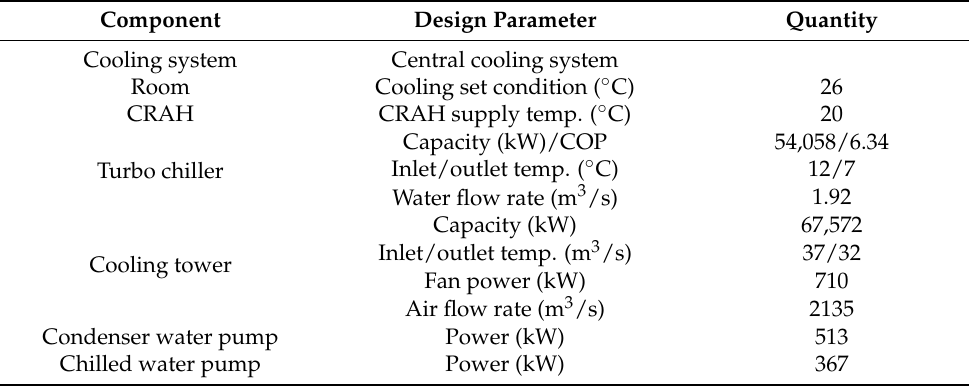
Figure 3. Schematic diagram of a central cooling system. Table 2. HAVC system specifications.